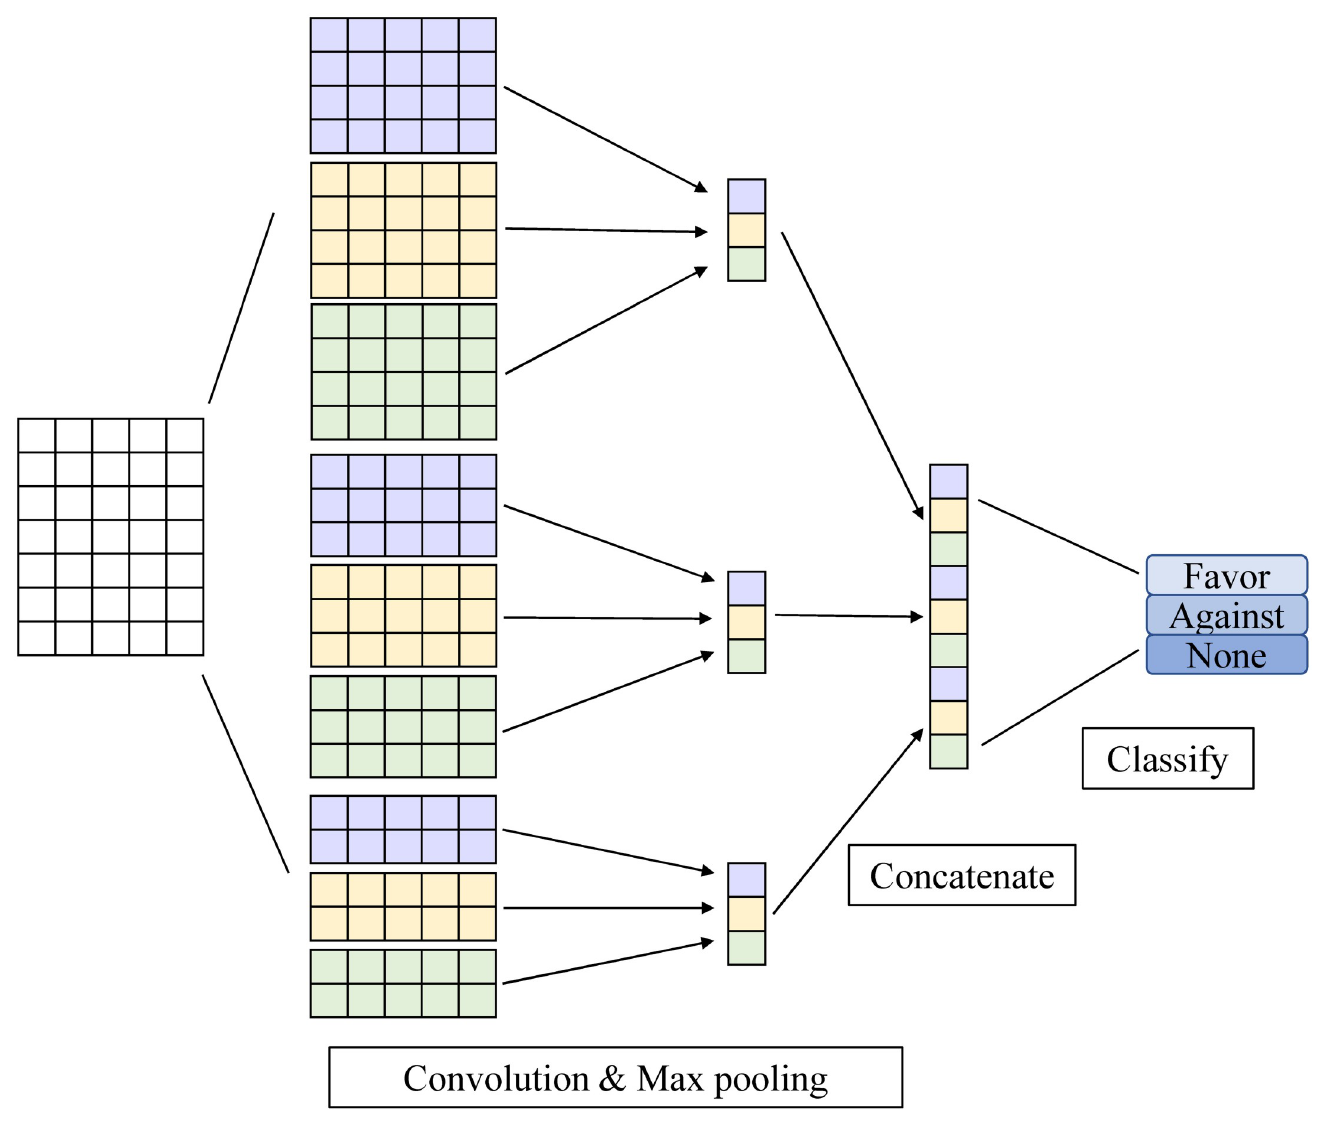
Fig 4. Text-CNN as the student